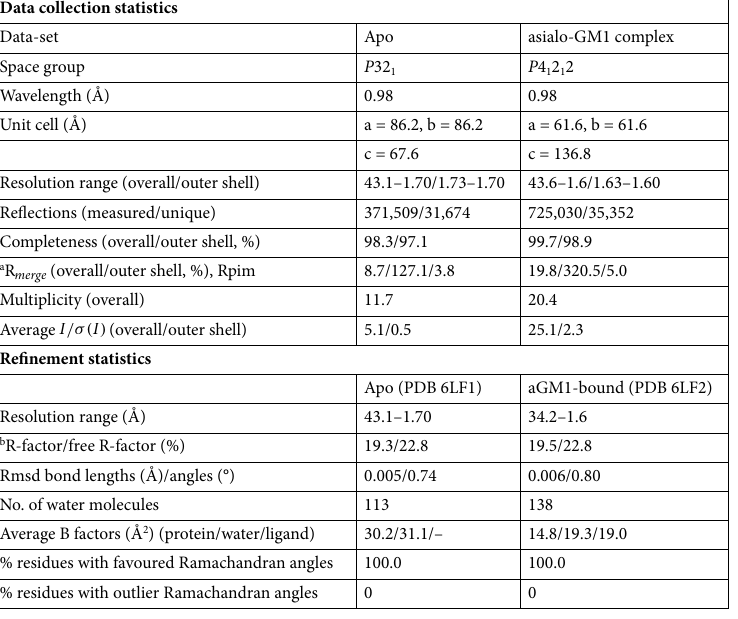
Table 1. a Rmerge = (cid:31) I i − � I � / (cid:31) I i , where I i is the intensity of an observation and (cid:31) I (cid:30) is the mean value for this reflection, and the summations are over all reflections. Values in parentheses are for the highest resolution shell. b R factor is � h || Fo ( h ) | − | Fc ( h ) || /� h Fo ( h ) , where Fo and Fc are the observed and calculated structure factor amplitudes, respectively. The free R factor was calculated with 5% of reflections omitted from the